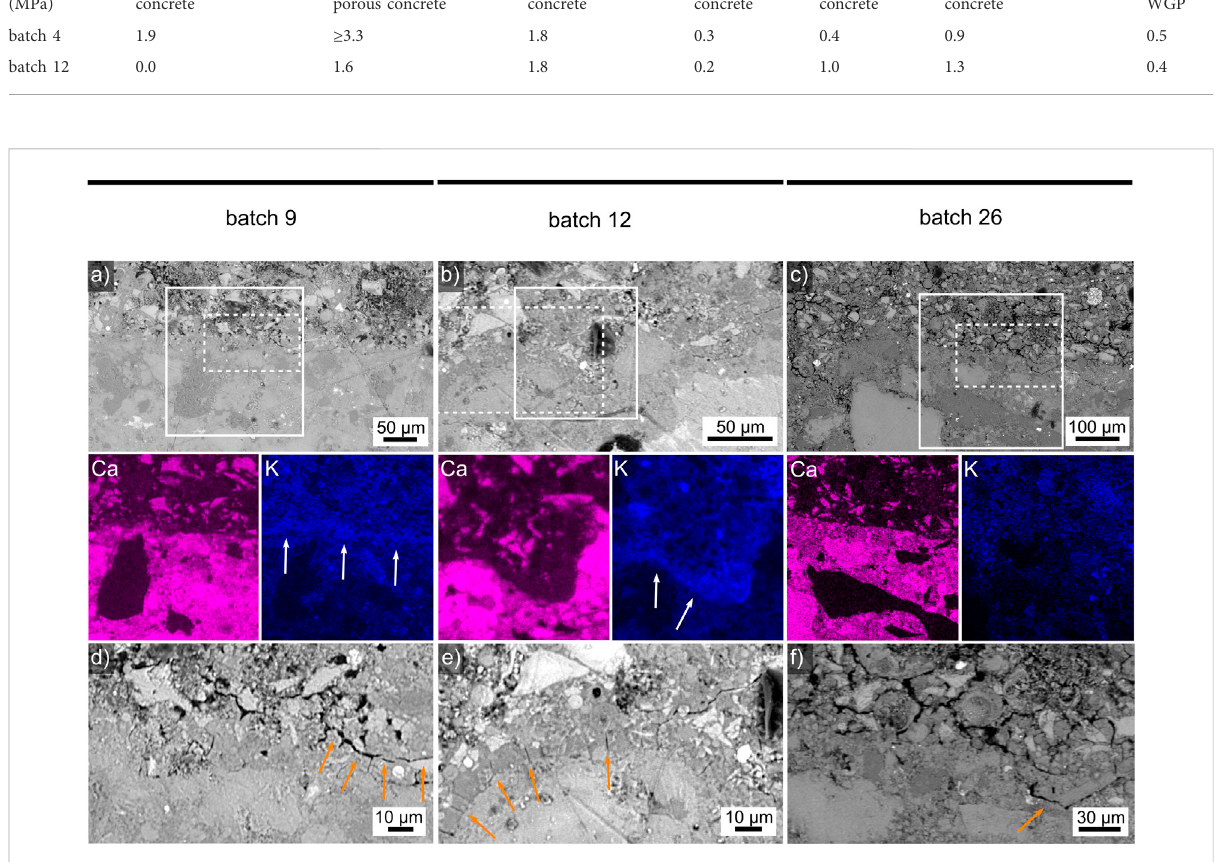
FIGURE 3 SEM micrographs between concrete (bottom) and the adhesives (A) 1, (B) 4 or (C) 12 (top of each fi gure). Selected EDXS element maps of the solid-framed areas are respectively presented below where white arrows highlight the concrete/adhesive interface. The dash-framed areas